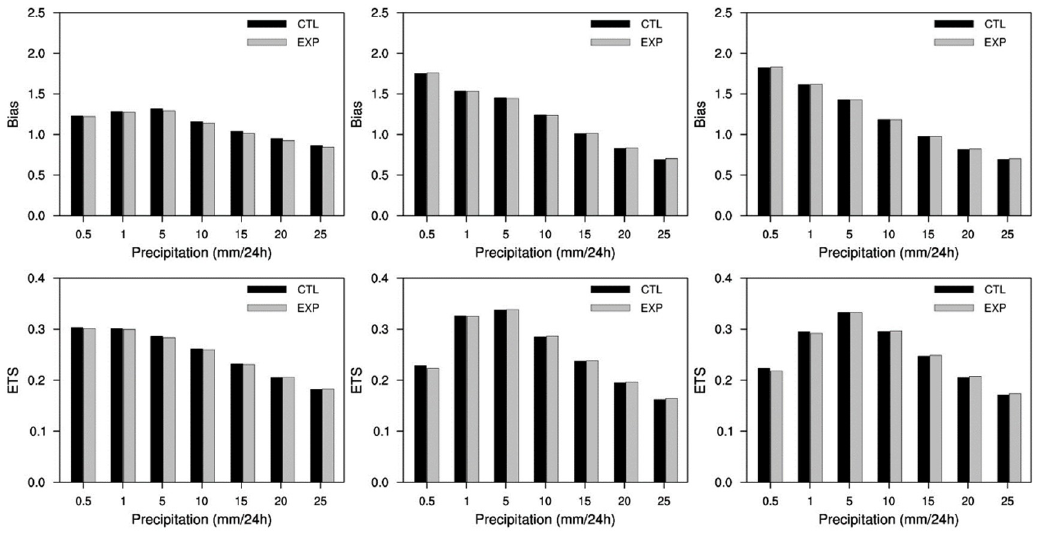
Figure 7. Comparison of ( upper ) bias scores and ( lower ) ETS against TRMM) Multi-Satellite Precipitation Analysis (TMPA) for the ( left panel ) Asia region, ( center ) tropics, and ( right panel ) global in CTL and EXP runs. Scores are shown as black bars for CTL and gray bars for